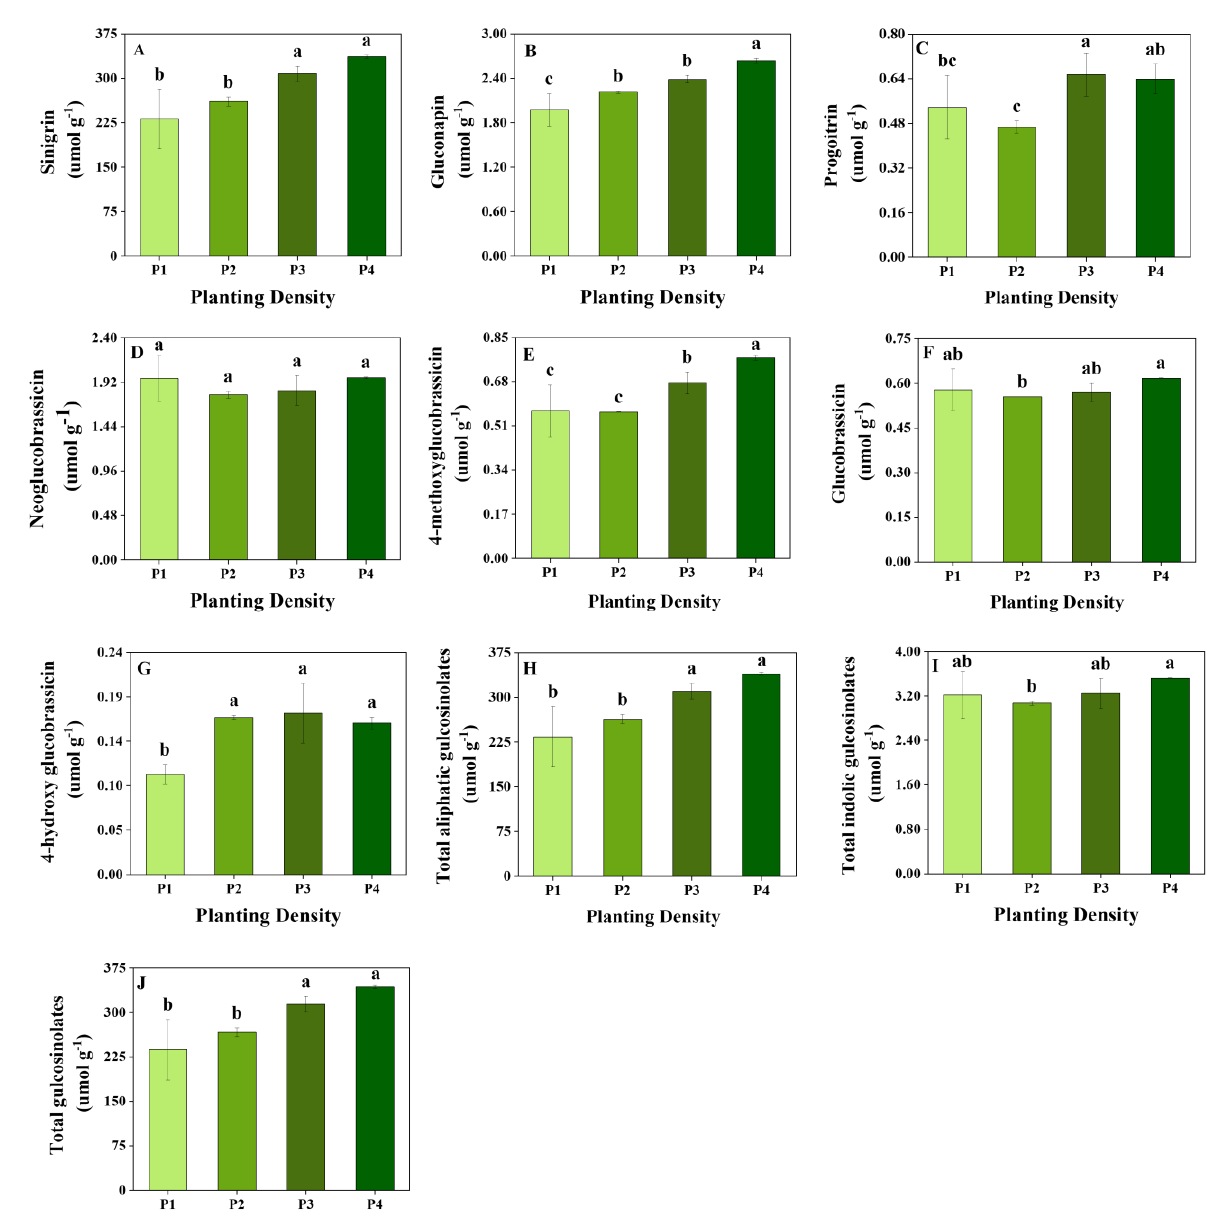
Figure 2. Glucosinolate content under different planting densities in mustard sprouts. Data are ex-